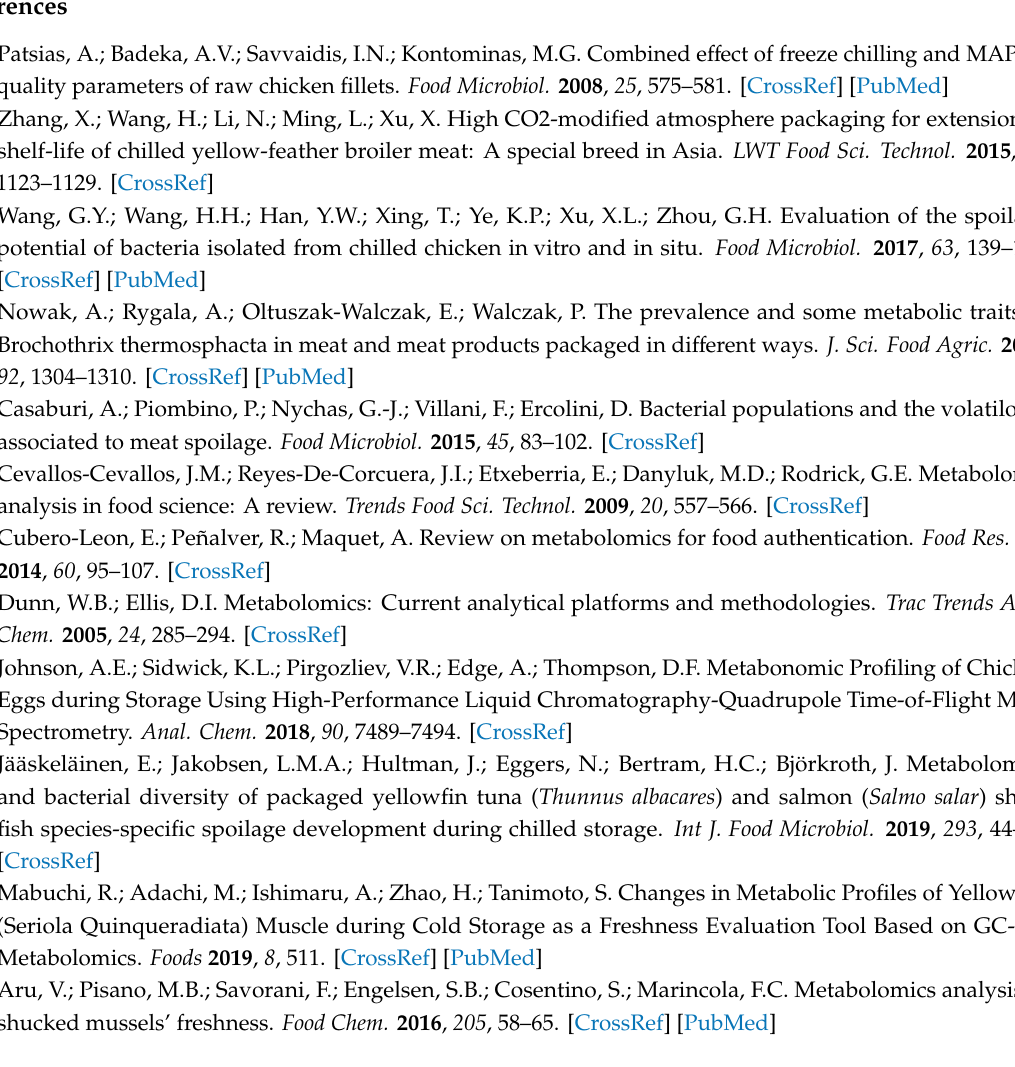
Table S1: The diet needs of Haiyang Yellow Chickens, Table S2: Integrated list of the 12,522 peaks detected by using the nontargeted metabolomics, Table S3: List of the 546 metabolites annotated based on the secondary spectrometry data, Table S4: Di ff erential metabolites during storage of chilled chicken, Table S5: Potential biomarkers screened using the random forest method. Figure S1: Base peak ion chromatograms (BPCs) of blank samples, Figure S2: Base peak ion chromatograms (BPCs) of chilled chicken samples at di ff erent storage time, Figure S3: Heatmap clustering of the di ff erential